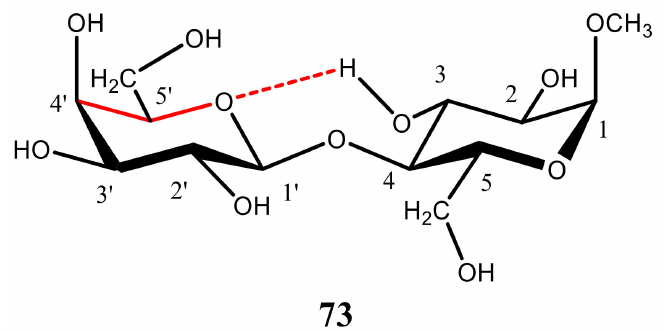
Figure 38. A representative structure of methyl α -lactoside methyl β -D-galactopyranosyl-(1 → 4)- α - D-glucopyranoside used to find the evidence of the intramolecular hydrogen bonding involving the hydroxyl group at the C 3 and O atoms of the adjacent pyranosyl